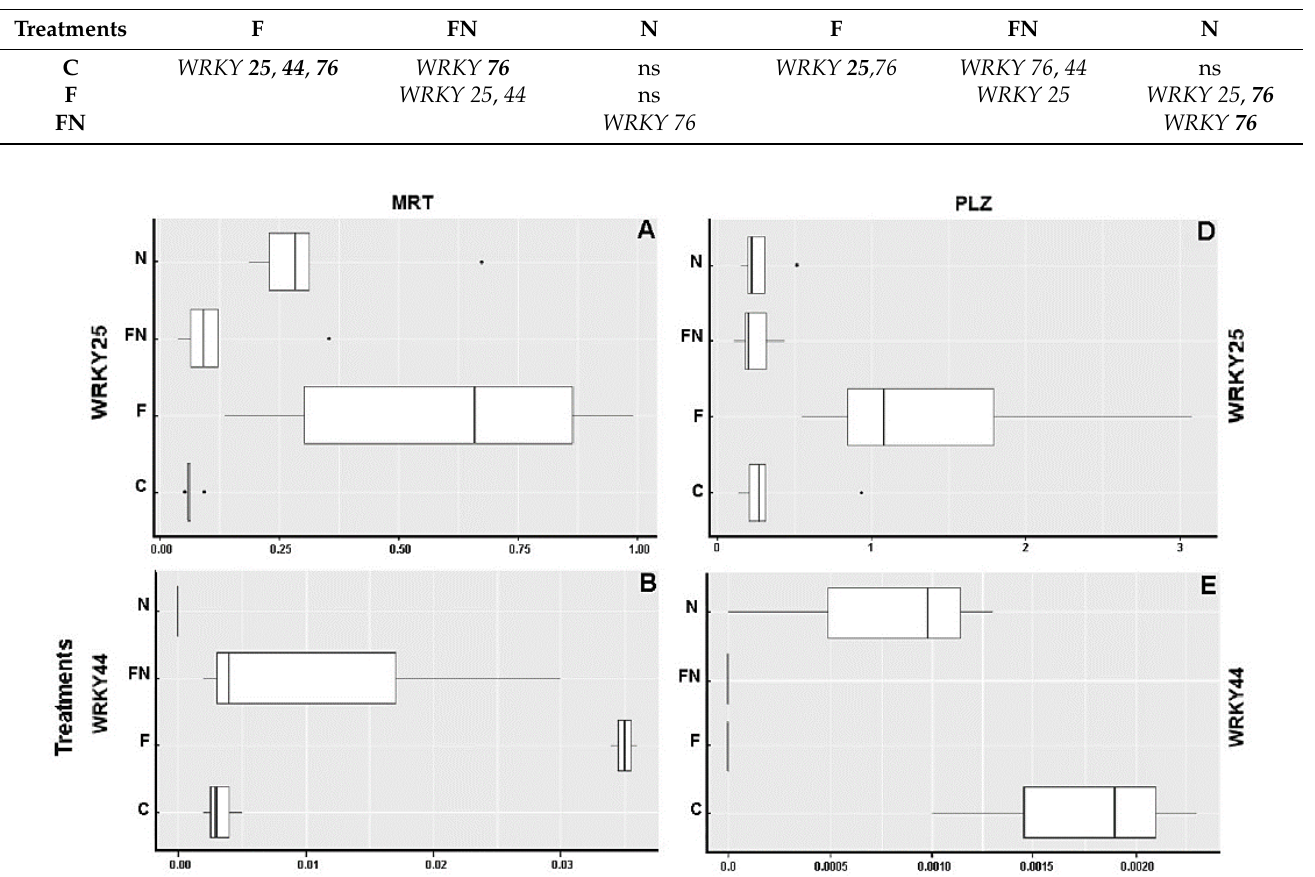
Figure 2. Expression of WRKY 25 , 44 and 76 genes in tomato accessions MRT ( A – C ) and PLZ ( D – F ). Each boxplot displays the first and third quartiles (lower and upper hinges), the median (vertical bar in the box), and the largest and smallest value (upper and lower whiskers), with outlying indi- vidual points (see Table 2 for description of treatments). Gene expression levels are shown along the x-axes as relative quantities of transcripts compared to the actin normalizer gene. Accession PLZ showed activation of the selected WRKY genes that was partially dif- ferent from MRT. The highest upregulation level of WRKY 25 was found in the PLZ roots inoculated with P. chlamydosporia , compared with the other conditions (C, FN and N), which showed similar expression levels (Table 2, Figure 2D). No significant difference from MRT was also observed for WRKY 25 in the presence of M. incognita , although at 8 dpi, a lower number of transcripts was found. The amount of WRKY 44 transcripts in PLZ was around 10-fold lower compared with MRT accession. Its expression was highest in the control and reduced in the double interaction with the endophyte (F and FN). Simi- larly, F and FN roots showed lower expression of WRKY 76 compared with either the C or N treatments (Figure 2D and Table 2). 2.3. Defense Gene Expression The expression of defense genes differed between the two tomato genotypes, as well as among some of the conditions tested (Table 3, Figure 3). In MRT, inoculation with M. incognita downregulated PR1 in the treatments with nematodes, with or without P. chla- mydosporia . This gene was expressed at higher levels in the control plants or in those inoc- ulated with the fungus alone. In this accession, transcript coding for PIN II showed the